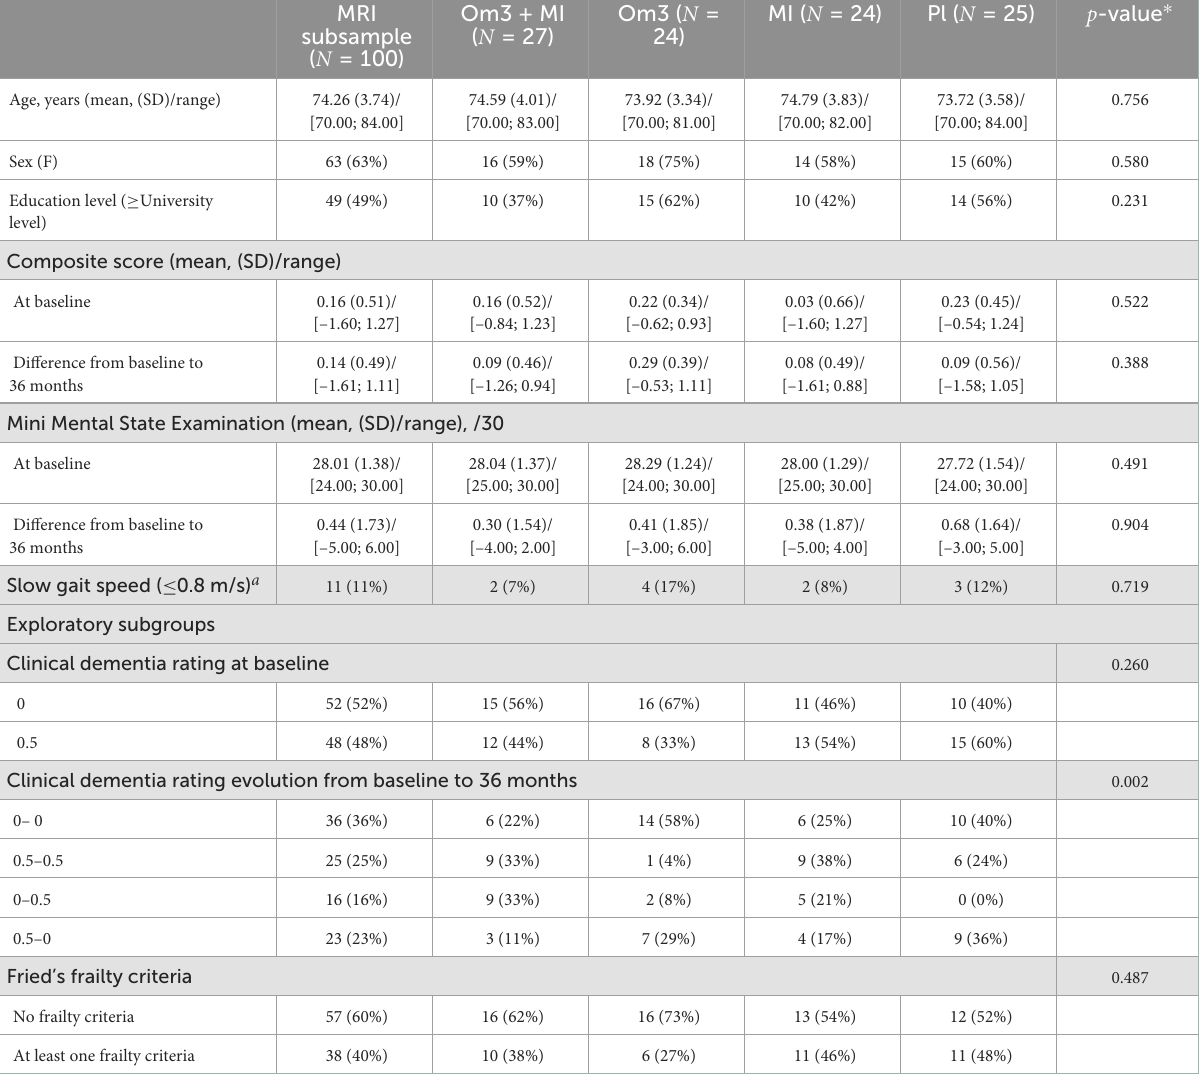
TABLE 1 Whole MAPT MRI subsample characteristics and comparison between the different intervention